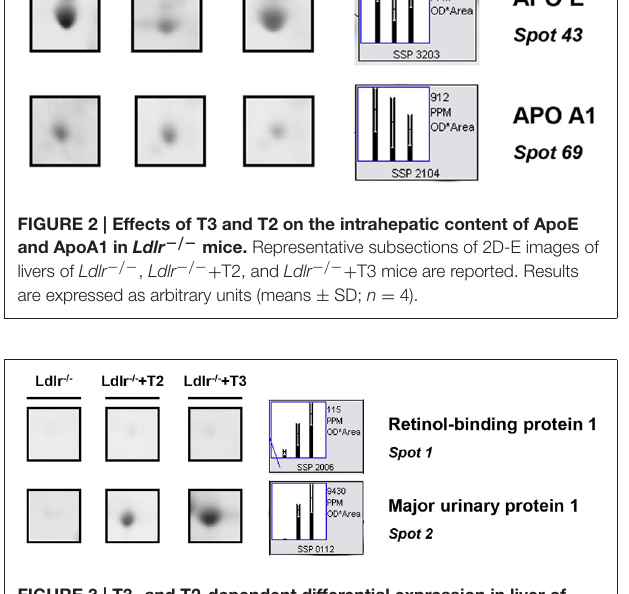
FIGURE 3 | T3- and T2-dependent differential expression in liver of Ldlr − / − mice: increased proteins. Representative subsections of 2D-E images of livers of Ldlr − / − , Ldlr − / − + T2, and Ldlr − / − + T3 mice. Results are expressed as arbitrary units (means ± SD; n = 4) ( p < 0.05).